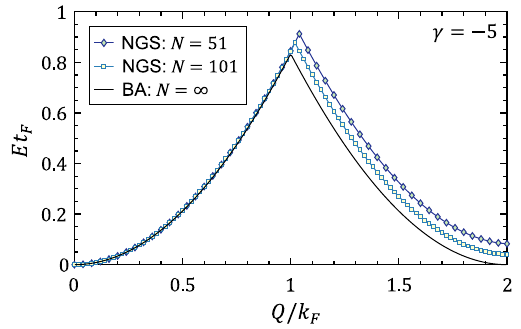
FIG. 4. Polaron energy-momentum relation for the case of attractive coupling γ < 0 (here we fix Λ ¼ 10 k our variational calculation nicely reproduces the BA result, adopted from Refs.